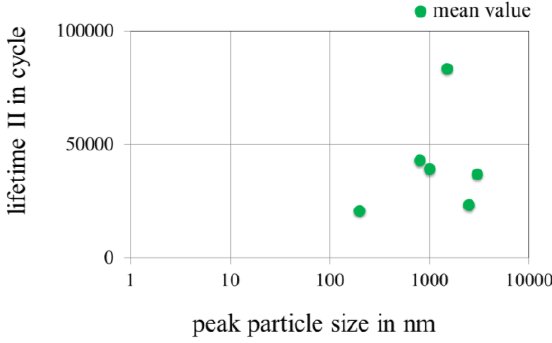
Figure 24. Effect of peak particle size in electrolytes. Number of measurements: